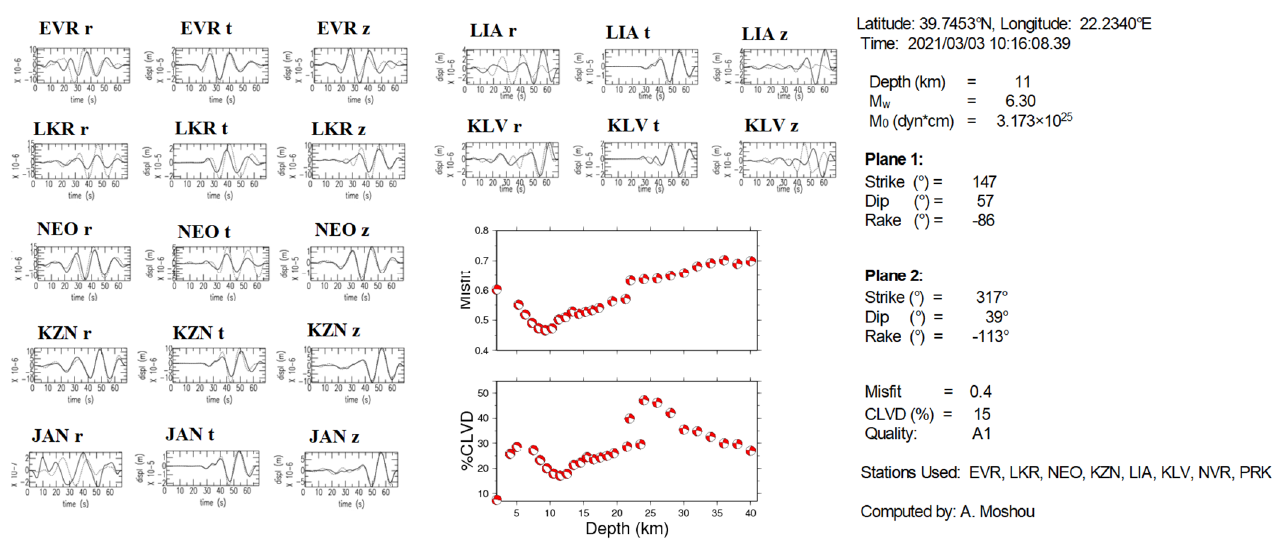
Figure 9. Inversion results for the first mainshock of 3 March 2021 (10:16:08.3 UTC). The left of the misfit/CLVD diagrams observed and synthetic displacement waveforms (continuous and dotted lines, respectively) are shown at the inverted stations for the radial, tangential, and vertical components. The solution’s summary and the fault plane solution as a lower hemisphere equal-area projection are depicted in the right part of the figure.